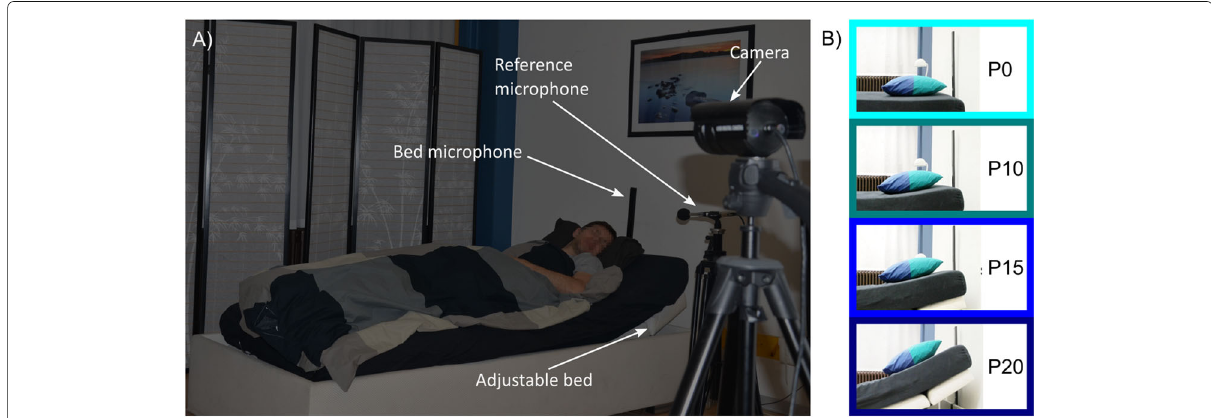
Fig. 1 Measurement setup. a Postural interventions were provided using an automated bed, which can elevate the trunk of the sleeping user. A custom-made built-in microphone was used to trigger trunk elevation. In addition, a reference microphone and a IR-camera were used to monitor the user. b The inclination angles provided by the bed were 10° (P10), 15° (P15), and 20° (P20) provided at the location where the users hip joint is to be expected. At the beginning of the night on during episodes of silence the bed was set to neutral postion